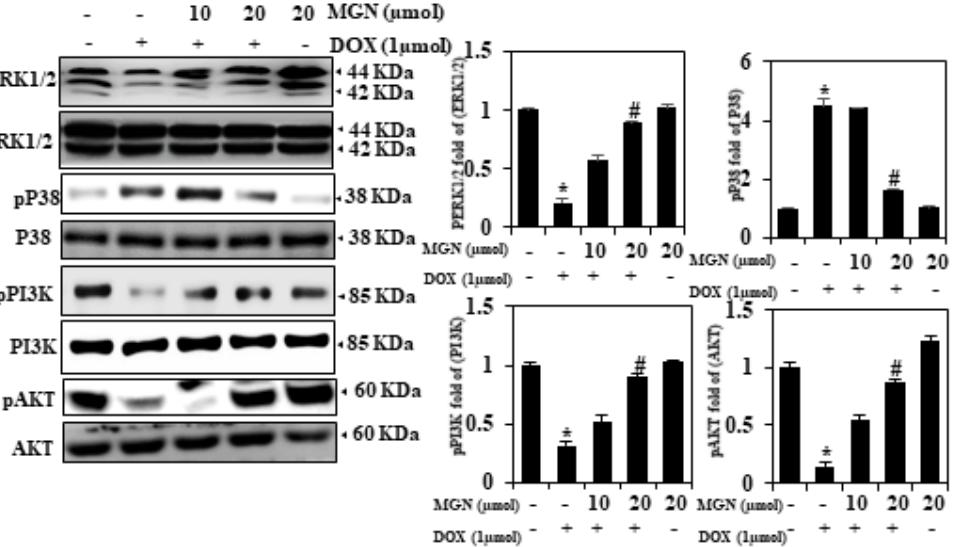
Figure 3. MGN’s influence on cell survival proteins. Cells have been treated with MGN and/or DOX (10 or 20 µ M) for 24 h. Whole-cell lysate was examined by pERK, p-PI3K, pP38, or p-AKT in Western blot. Total ERK, P38, AKT, and PI3K levels were evaluated as loading controls. The outcome was measured and expressed as a fold change compared to the control ( n = 3). Data are mean ± SEM. One-way ANOVA plus Tukey’s post hoc analysis analyzed the comparison between groups. * p < 0.05 reflects significant differences from the healthy control. # p < 0.05 reflects significant differences in contrast to DOX alone or MGN with DOX-treated groups.